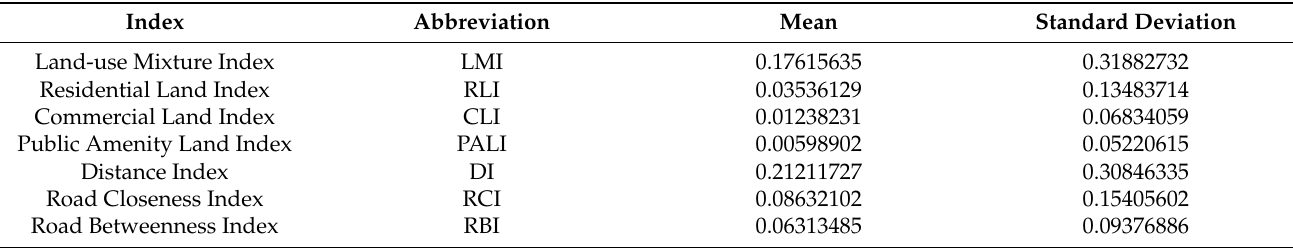
Table 1. Descriptive statistics of